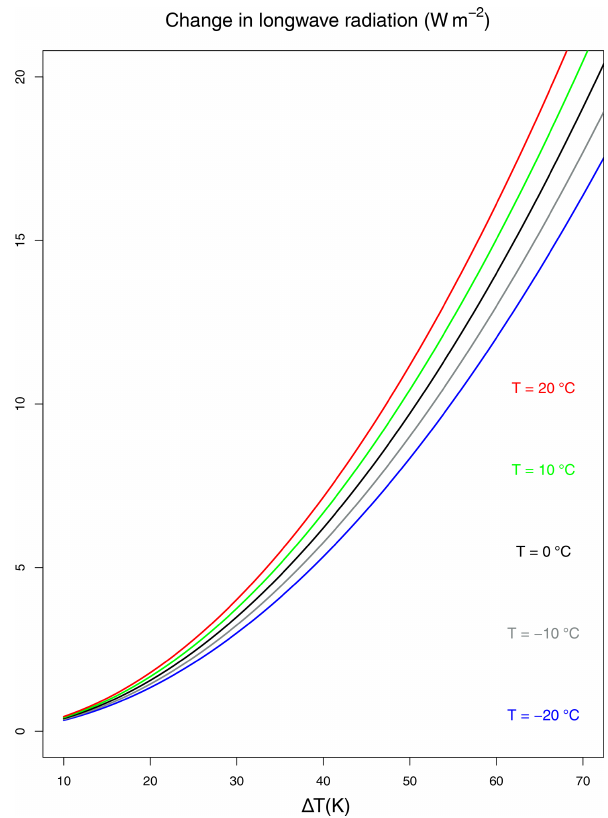
Figure 9. Longwave radiation change with seasonal amplitude of temperature (cid:49)T for different temperatures T .